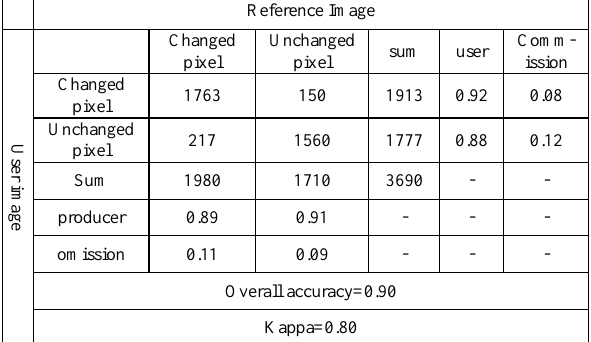
Table 17. Error matrix of Change detection result of object- oriented method combined dNDVI with